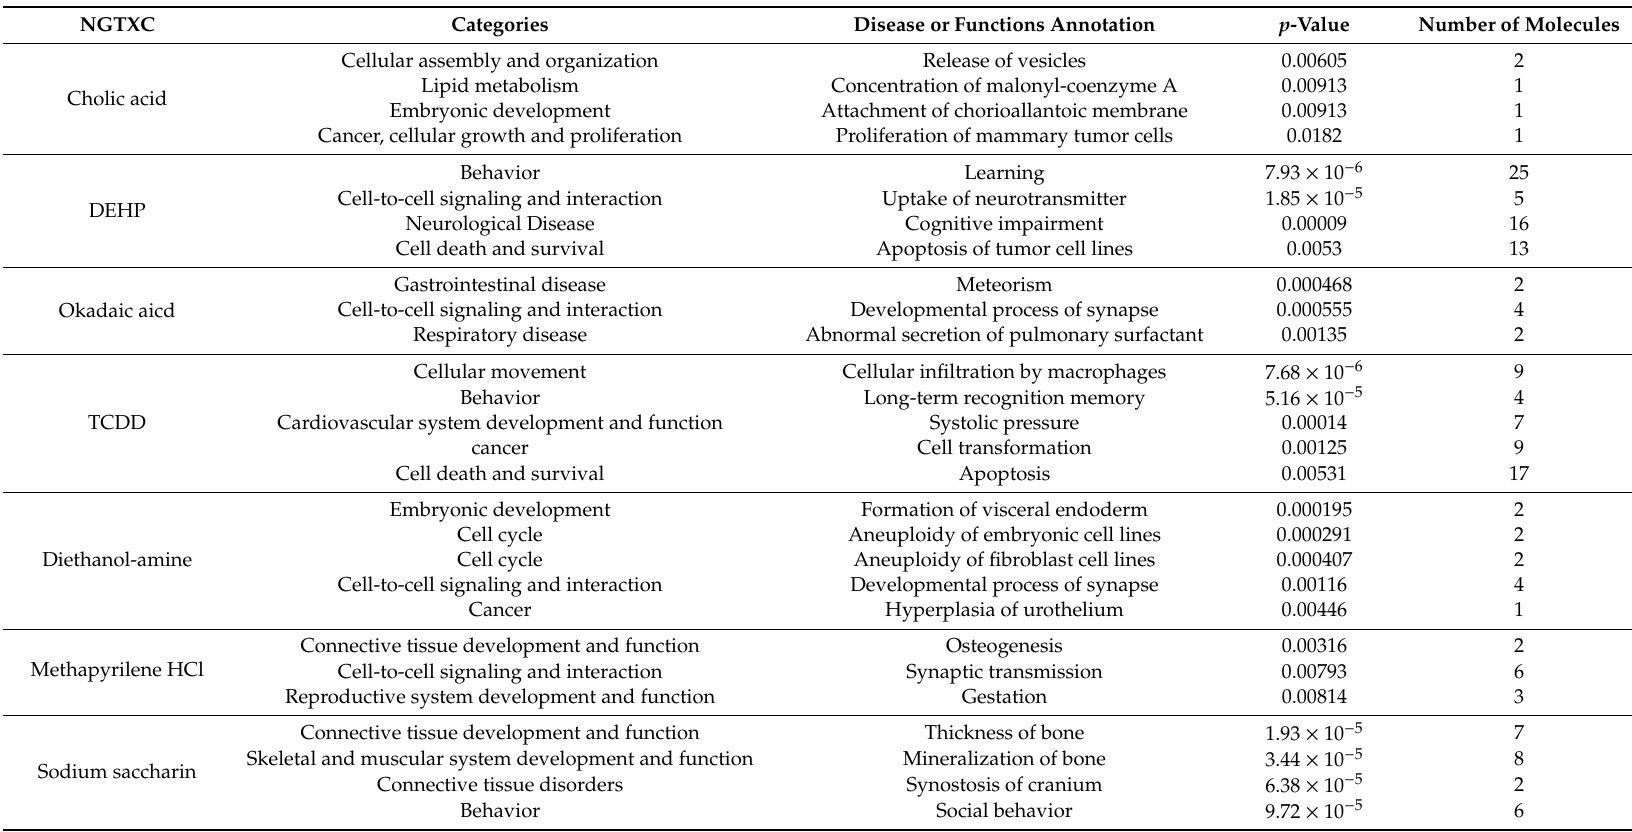
Table 5. Top 3 and significant enriched functional annotations of the di ff erentially methylated regions between the control and the NGTXC-treated group ( p -value < 0.05 and proportion of methylation di ff erence >